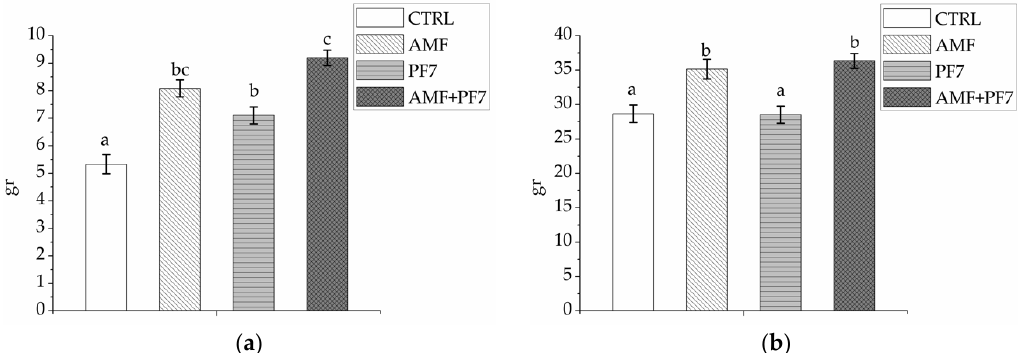
Figure 4. Average dry weight of shoots ( a ) and roots ( b ) in the mesocosm experiment. Different letters indicated that the differences among the means were significant (p-value <0.05).